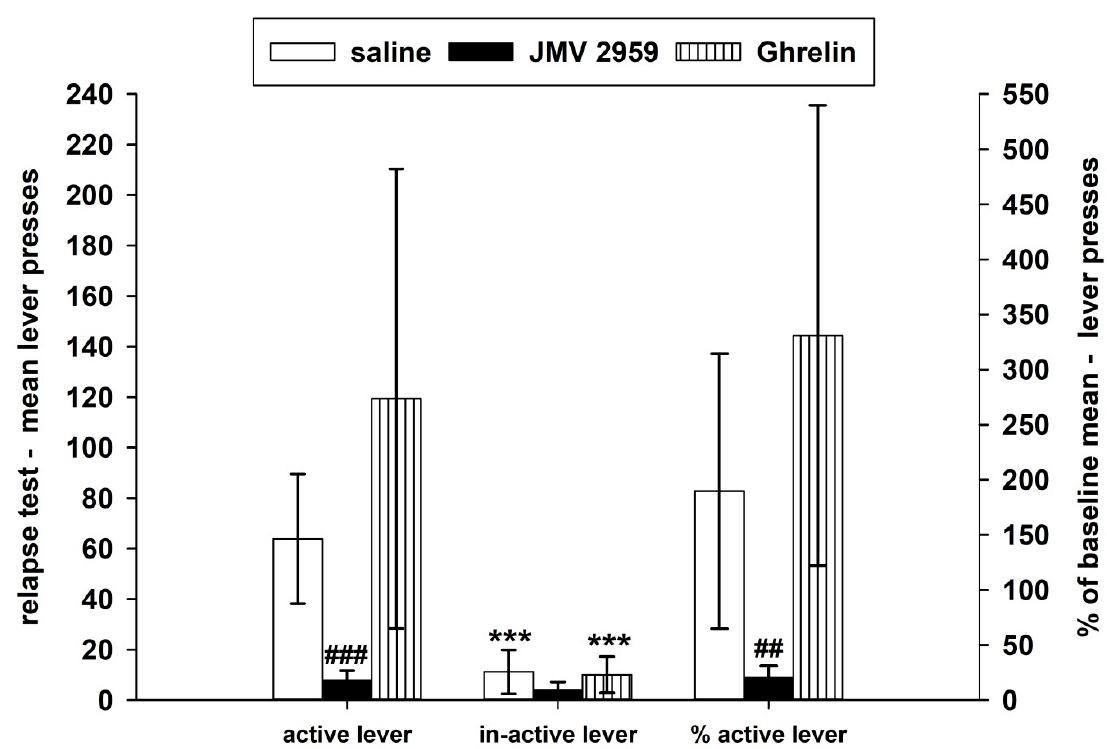
Figure 4. Effects of JMV2959 and ghrelin on WIN55,212-2-seeking lever-pressing/relapse-like behavior, observed on the twelfth day of forced abstinence of the WIN55,212-2 intravenous self-administration (IVSA) in active/inactive lever-pressing and percentage of the baseline mean (mean of the last three baselines before pretreatments, 5.-7. bas). Saline (1 mL/kg) or JMV2959 (3 mg/kg) or ghrelin (40 µ g/kg) were administered intraperitoneally 20 min before the 120-min session, when the rats were in the IVSA cages not connected with the infusion pump. The IVSA relapse-test data went through logarithmic transformation before the statistical analysis; thus, in the graphs are presented original data together with significances obtained from the transformed ANOVA results. However, the percentage data were analyzed directly/not transformed using the Kruskal–Wallis one-way analysis followed by a Dunn´s test. The means of active lever-pressing in the groups are presented as follows: Saline (open bar)( n = 9), JMV2959 (filled bar)( n = 10), ghrelin (striped bar)( n = 8). Differences between the groups in comparison to the saline group are expressed as ## p < 0.001, ### p < 0.01. Differences between active and inactive lever-pressing are expressed as *** p < 0.001. The results are presented as group means with 95% confidence intervals.